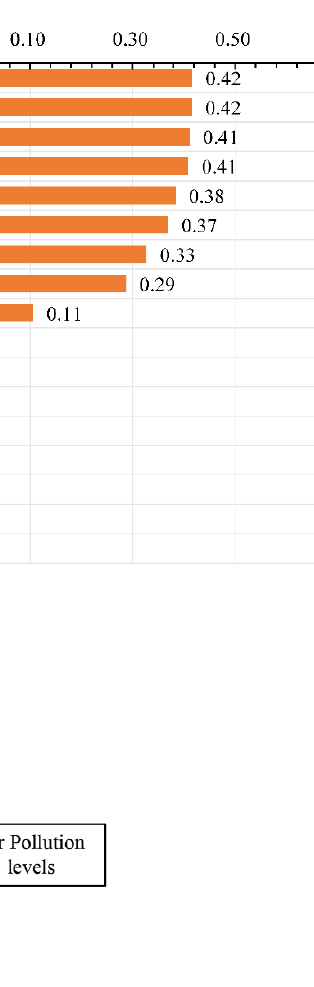
Figure 9. Analysis of the interaction mechanism of factors.